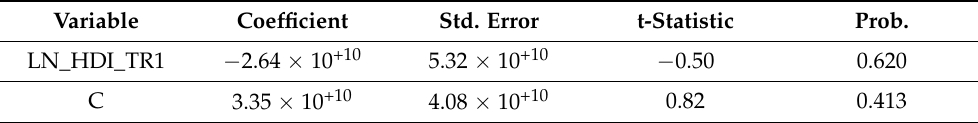
Table 7. Estimation for Turkey.